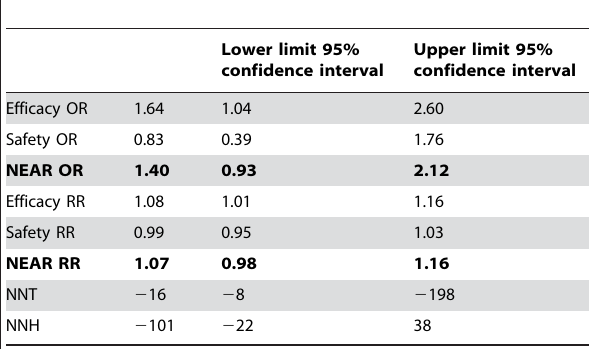
Table 6. Results of calculating NEAR and traditional efficacy and safety variables with data obtained from a CRT in which gemifloxacin was assayed versus trovafloxacin